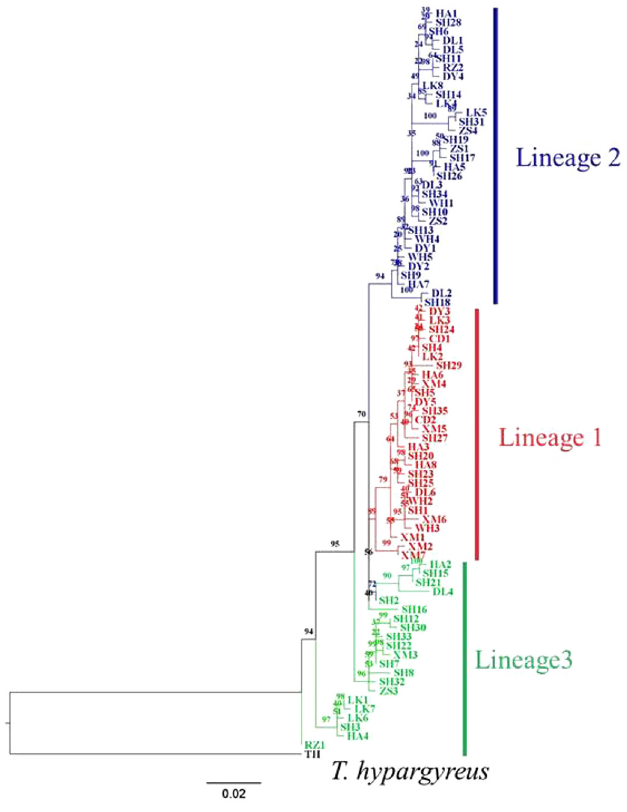
Fig. 5. Maximum likelihood (ML) tree of haplotypes in T. modestus .